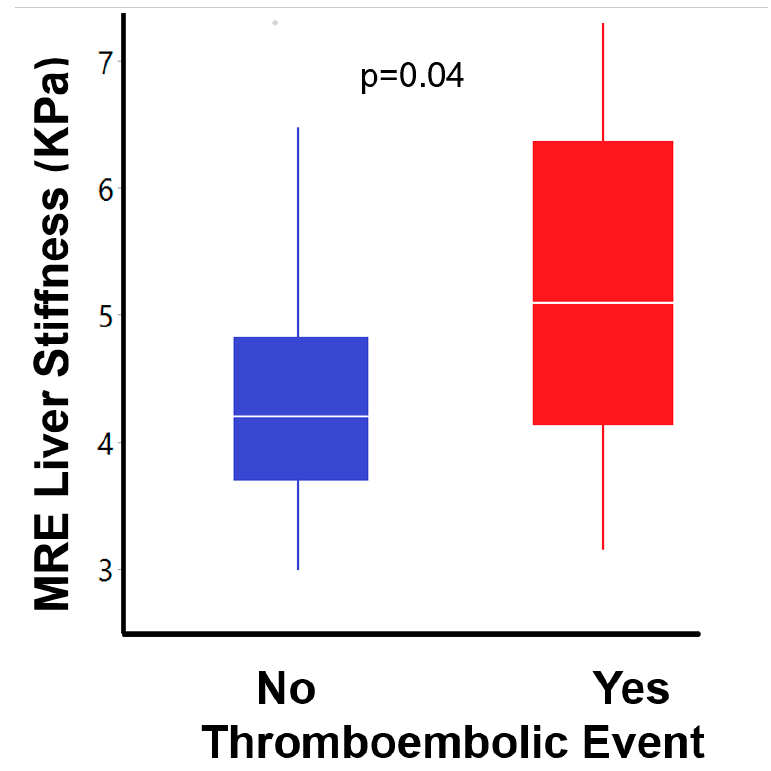
Figure 2. Magnetic resonance elastography shows increased liver sti ff ness in patients with a history of thromboembolic event represented as a Tukey box